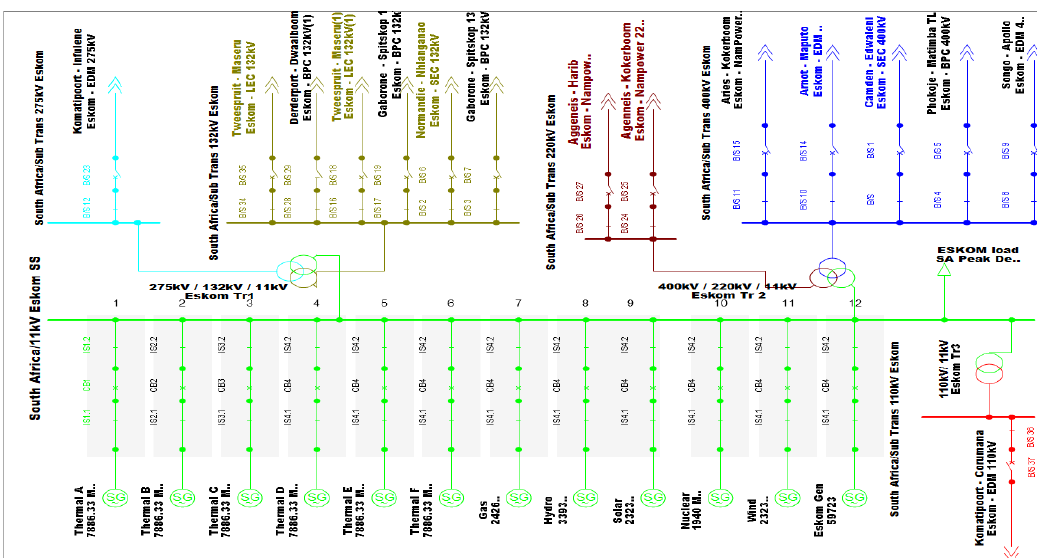
Figure 4. South Africa proposed a network model.